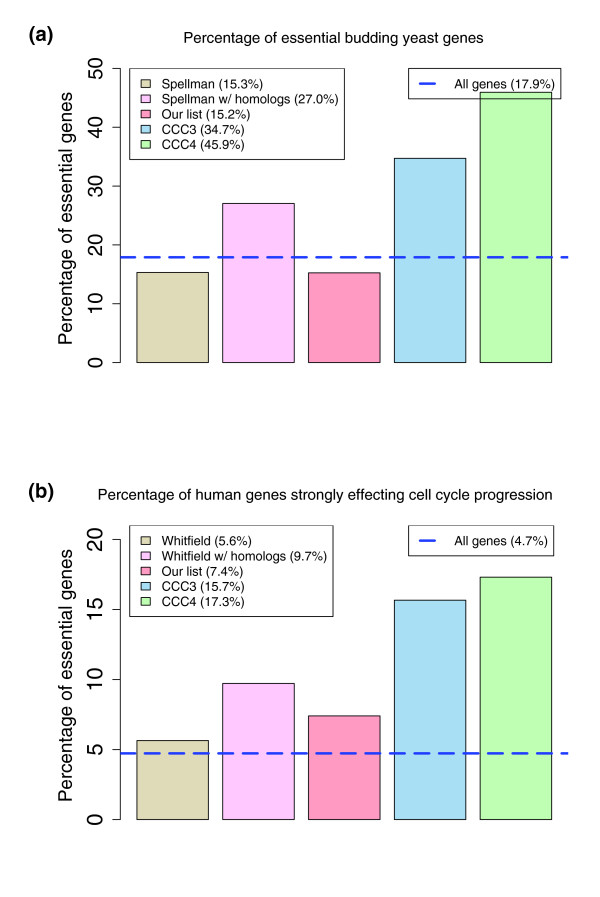
The importance of the core cycling genes. (a) Percentage of essential genes in different sets of budding yeast genes [29]. Although 18% of budding yeast genes are essential, only 15% of cycling genes are essential. Our analysis resolves this apparent contradiction by showing that the conserved cycling genes lists contain a much higher percentage of essential genes (35% and 46% for CCC3 and CCC4). Sequence alone cannot account for this high percentage (27%), indicating the importance of the combined analysis. (b) Similar analysis for the human lists using data from RNA interference knockdown experiments [30].